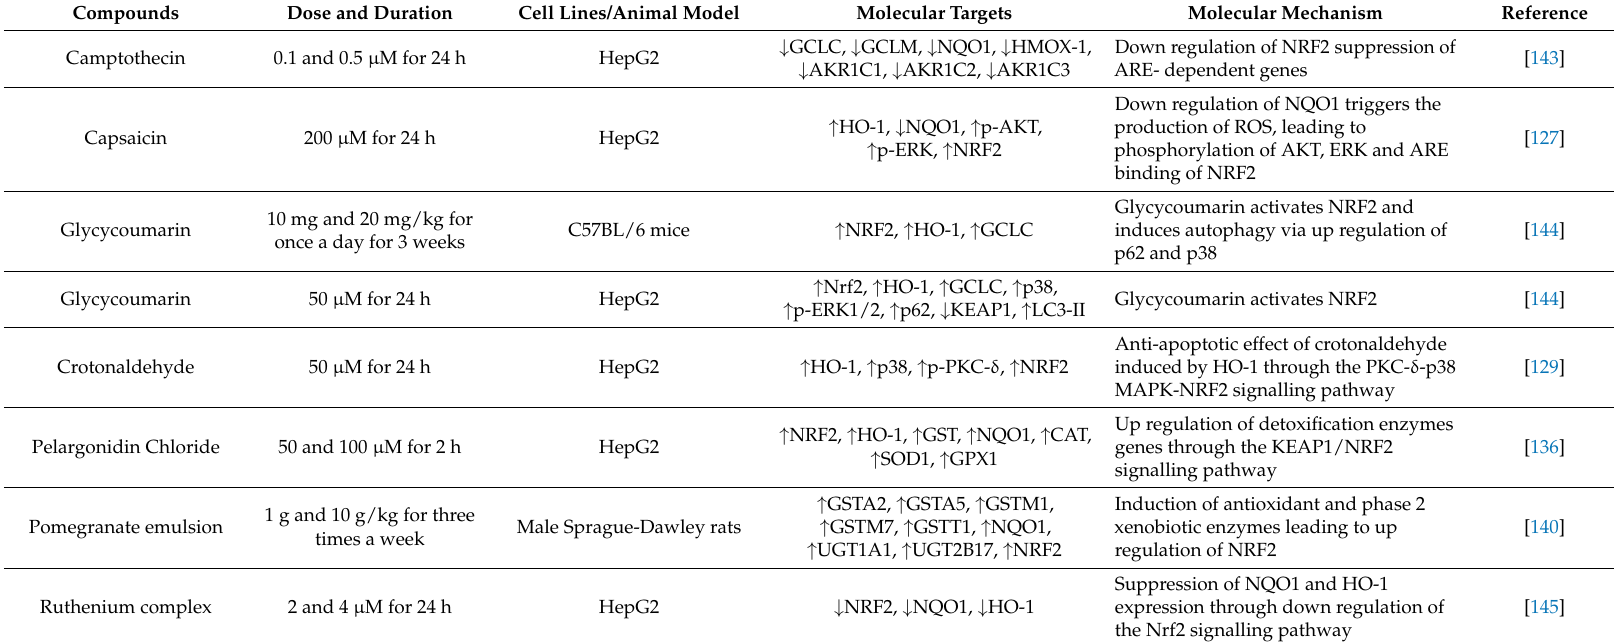
Table 1. Phytochemicals and molecules that target different molecules and modulate the Nrf2 pathway in